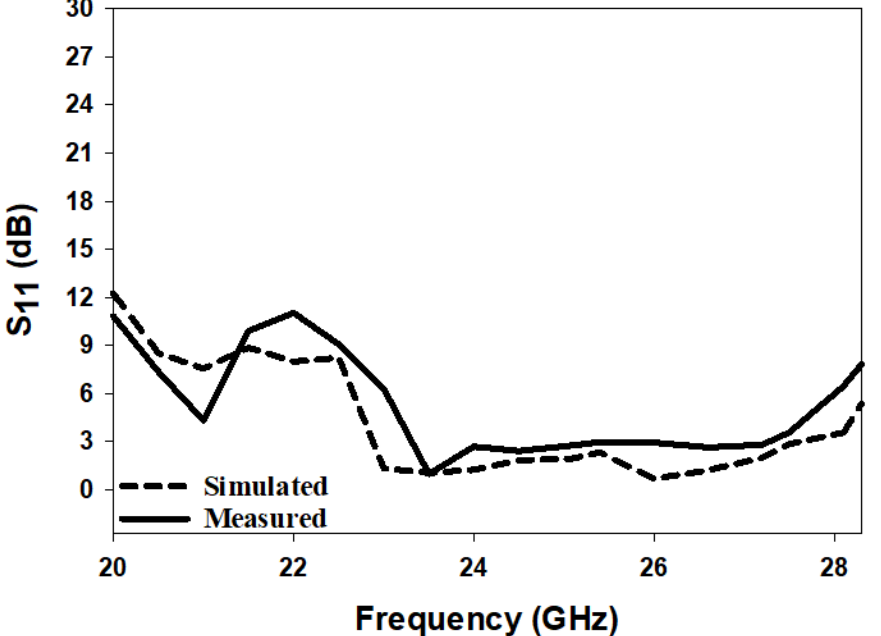
Figure 20. Axial ratio of a circularly polarised integrated hemispherical DRA and a perforated